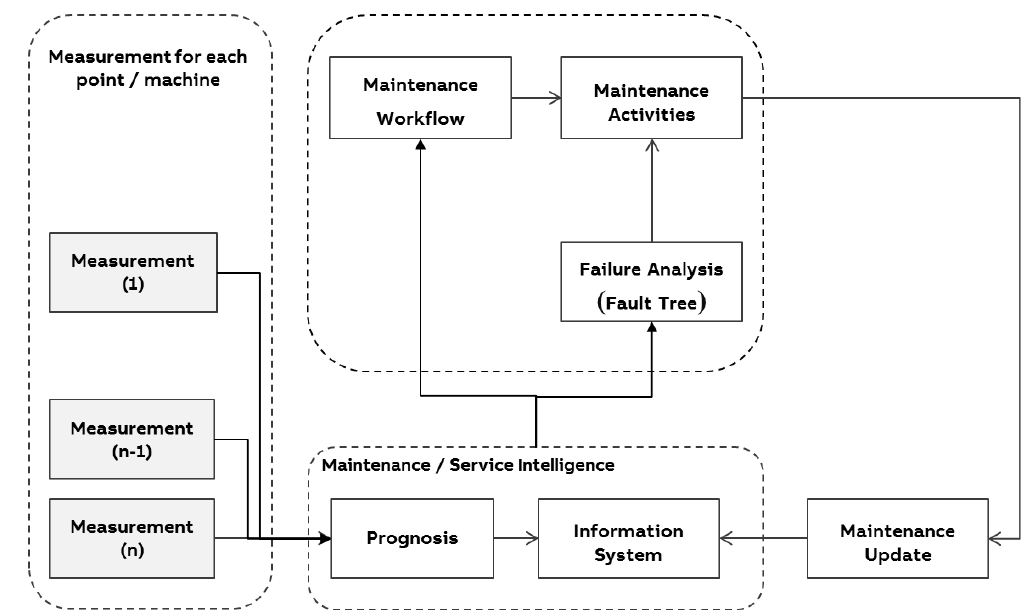
Figure 3. Condition based maintenance for plant-wide fleet monitoring.